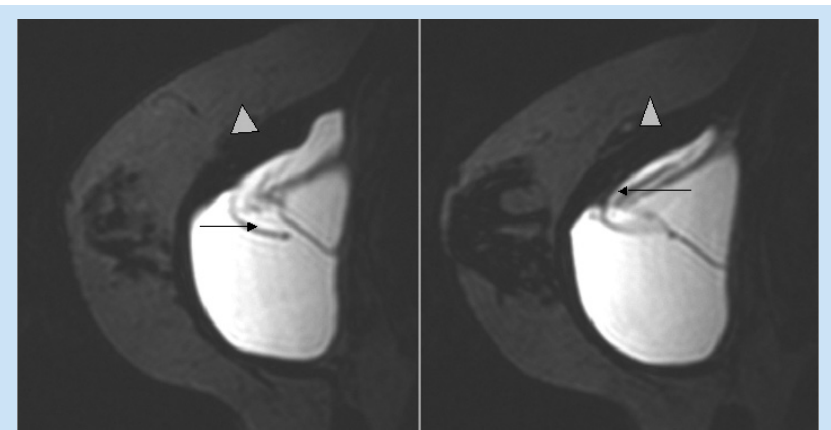
Fig.2.T2 sagittal scan demonstrates rupture of the elastomer shell superiorly (arrow) with escape of pros- thesis contents between the elastomer shell and capsule (arrowhead).